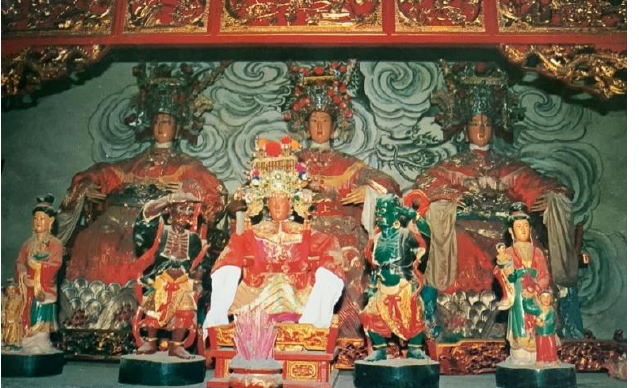
Figure 4. The Palong Temple in Xianyou County also houses three statues of goddesses in the same shrine. Source: author ’ s photograph.